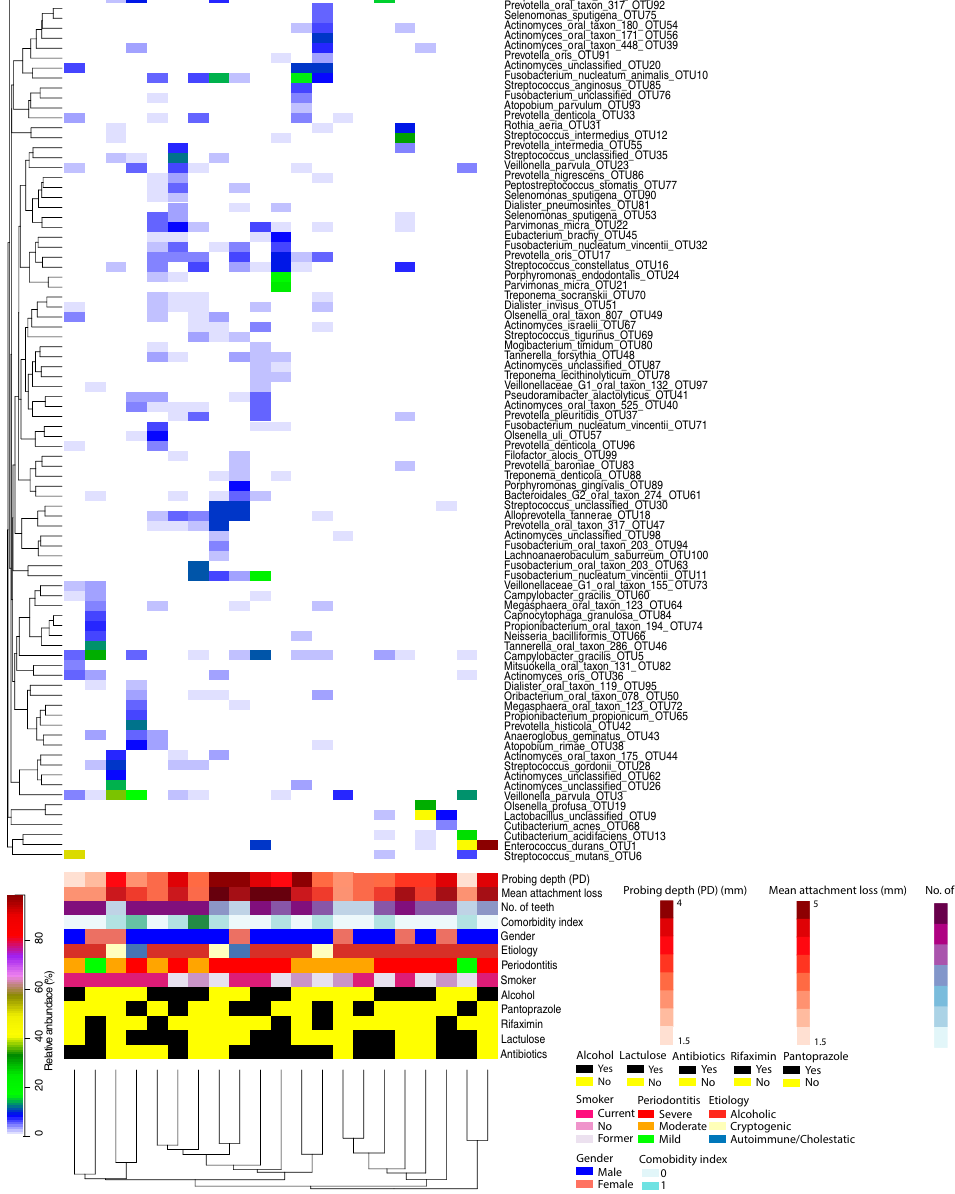
( C . rectus , C . showae , and F . periodonticum ) were not found in any of the samples. Interestingly, when species belonging to the orange complex accounted for less than 5% of the total population, as in seven of the sam- ples, species belonging to the red complex were completely absent. While there was no association between the